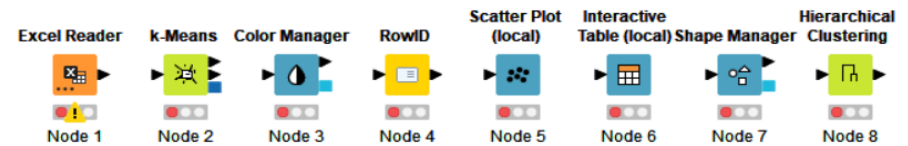
Figure 6. Representative elements (nodes) of a workflow in KNIME. (Node 1) spatial data; (Node 2) k-Means algorithm—perform clustering; (Node 3) assign colors to clusters; (Node 4) replace input data or create new row; (Node 5) create scatter plot; (Node 6) generate the table with afferent clusters; (Node 7) assign a shape to clusters; (Node 8) hierarchical—dendrogram. Source: authors’ compilation in KNIME analytics platform.